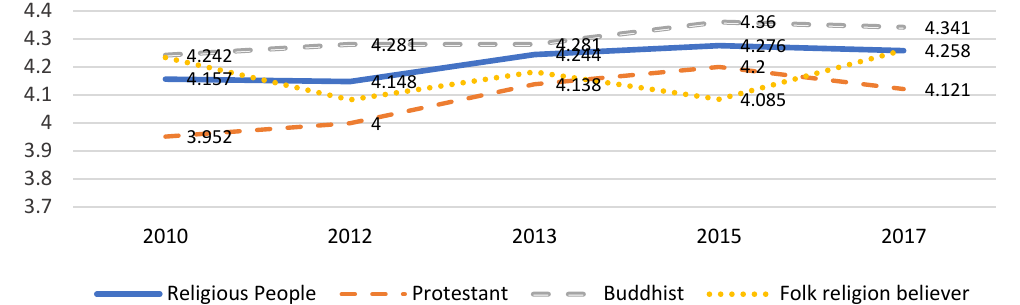
Figure 2. Tendencies in the age composition.